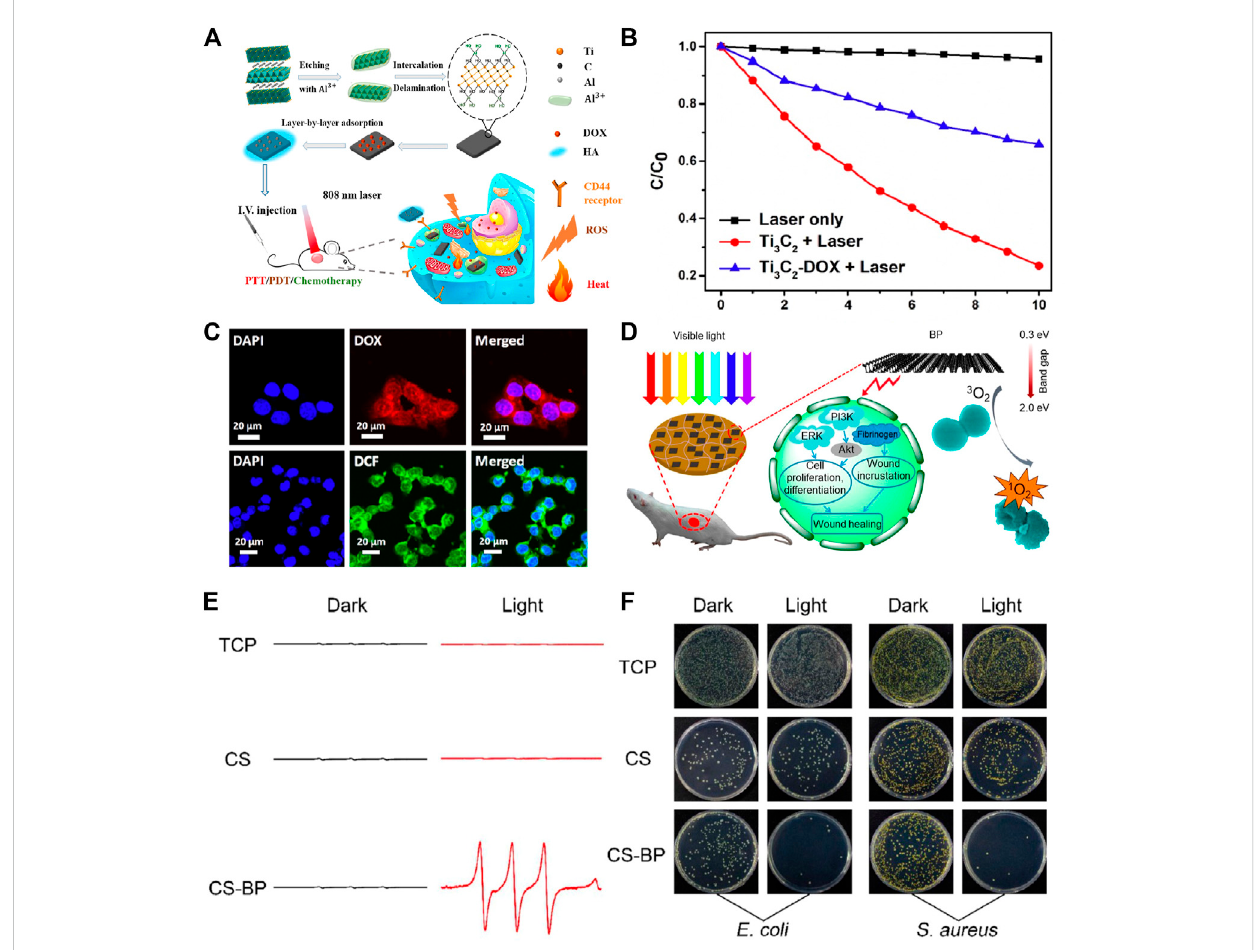
FIGURE 8 (A) SchematicillustrationoffabricationofTi3C2-DOXandtherapeuticstrategyofbasedonTi3C2-DOX. (B) AbsorbanceofDCPFindifferentgroups. (C) CLSM images ofHCT-116c cells incubatedwith Ti3C2-DOX after irradiation. (Adapted with permission from Liuet al., 2017. Copyright 2017 American ChemicalSociety). (D) SchematicillustrationoftherapeuticstrategyforbacterialinfectionandwoundhealingbasedonCS-BP. (E) ESPspectraindifferent groups. (F) Imagesofbacterialcolonyindifferentgroupsaftertreatments.(AdaptedwithpermissionfromMaoetal.,2018.Copyright2018American Chemical